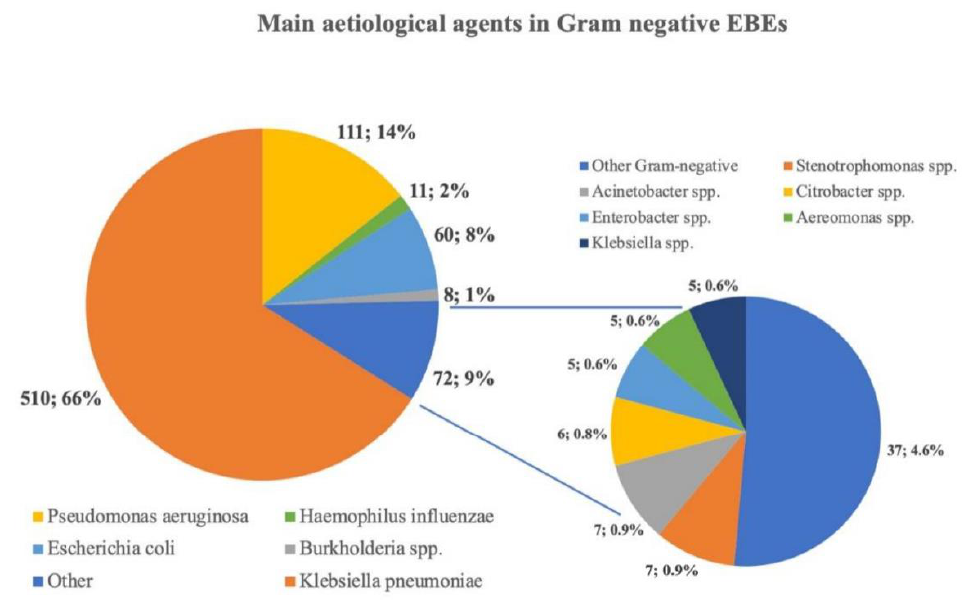
Figure 2. Prevalent aetiology found in this systematic review. Each pathogen included in the “Other” group represents less than 1% of the aetiology reported. Klebsiella spp. = Klebsiella other than K. pneumoniae .